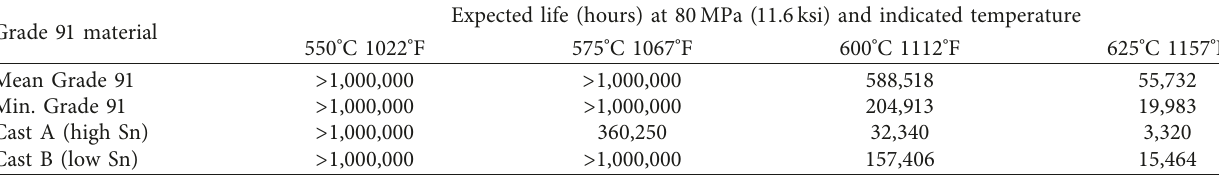
Table 3: Analysis of the effect of Sn on performance as a function of service temperature for a given stress of 80MPa (11.6ksi). Grade 91 material